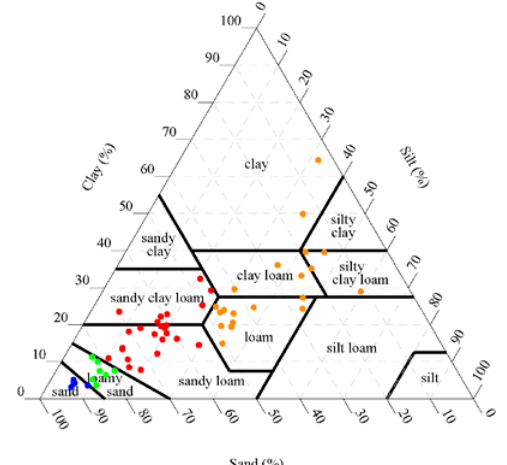
Figure 2. Soil texture distribution of the 56 stations used. Orange, red, green and blue colors represent fine, medium, coarse and very coarse texture, respectively.